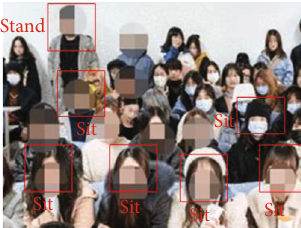
Figure 2: Determine the results of students ’ classroom dynamic behavior.